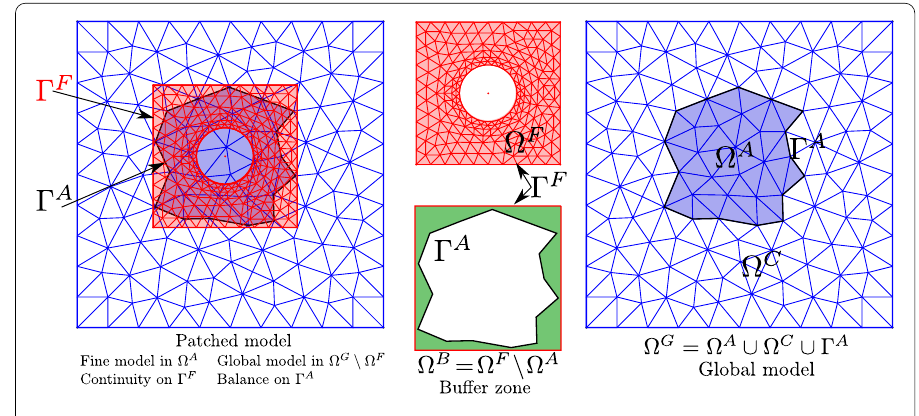
Fig. 8 Technique with overlap for non-conforming